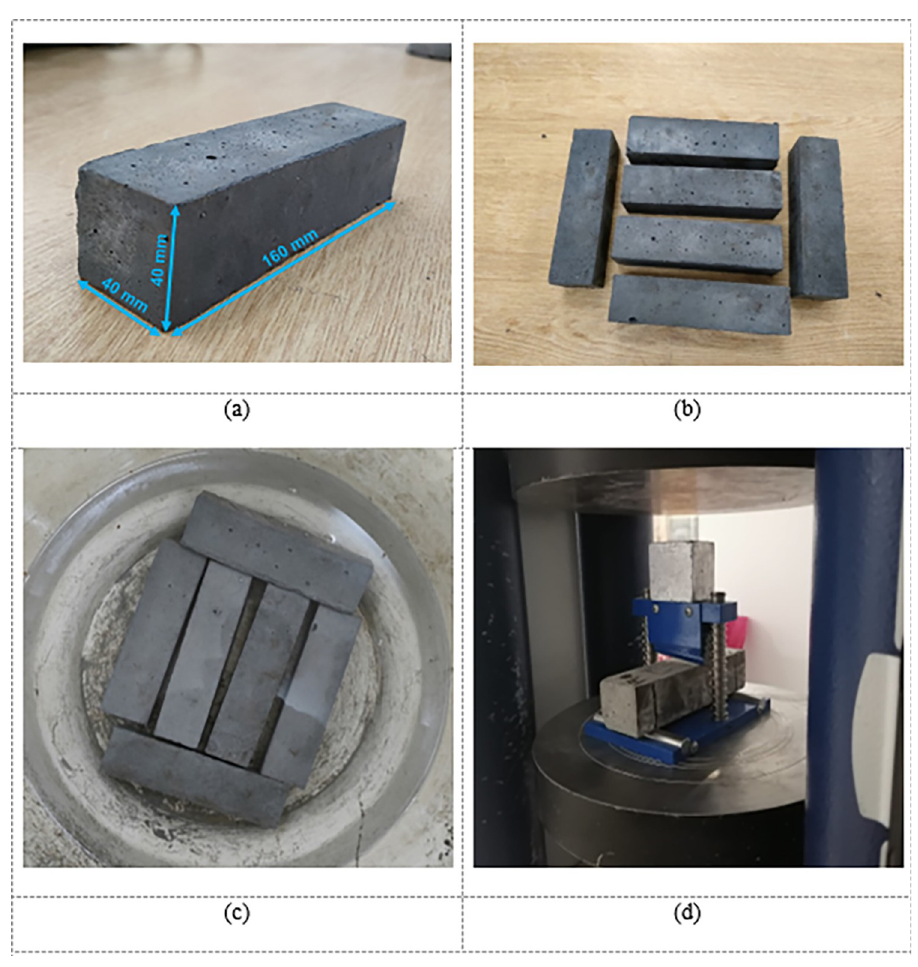
Fig 1. Images of the experimental program: (a) Dimensions of a specimen; (b) Specimens after demolding; (c) Water curing of specimens; (d) Testing assembly. calculated. The techniques used cement, water, fine aggregate, WGP, superplasticizer, and sil- ica fume as input features and FS as the output. Both single and ensemble ML algorithms were employed alongside Python code and the Spyder (version 5.1.5) from the Anaconda Navigator program. While BR was used as an ensemble ML approach, SVM was used as a single ML method. These ML techniques are frequently utilized to forecast desired outcomes using input parameters. These techniques might be used to estimate the strength of CCs, temperature effects, and durability [64,65]. For testing and training during the modeling phase, the alloca- tion of experimental data was 30% and 70%, respectively. The R 2 score of the predicted out- come indicates how well the models operated. The R 2 value suggests the level of variance; a number near 0 denotes greater variation, whilst a value nearby 1 suggests that the experimental results and prediction model are almost perfectly suited [66]. Additionally, ML models were subjected to statistical, k-fold, and error analysis, like mean absolute error (MAE), root mean square error (RMSE), and mean absolute percentage error (MAPE). Fig 2 shows the flowchart of the modeling program. The ML approaches and validation strategies used in this work are described in the following sub-segments.